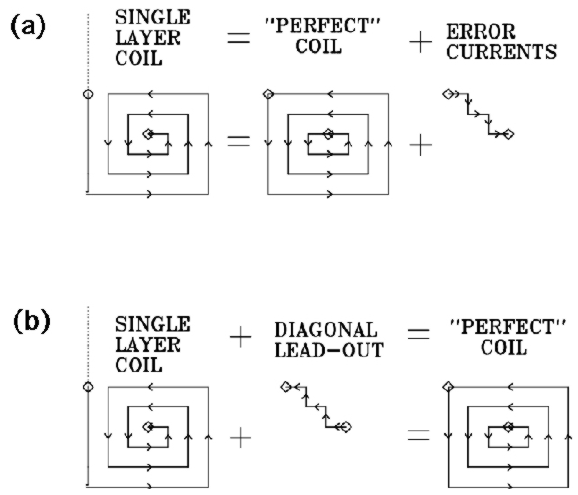
FIG. 17. Concept for correcting coil winding errors.